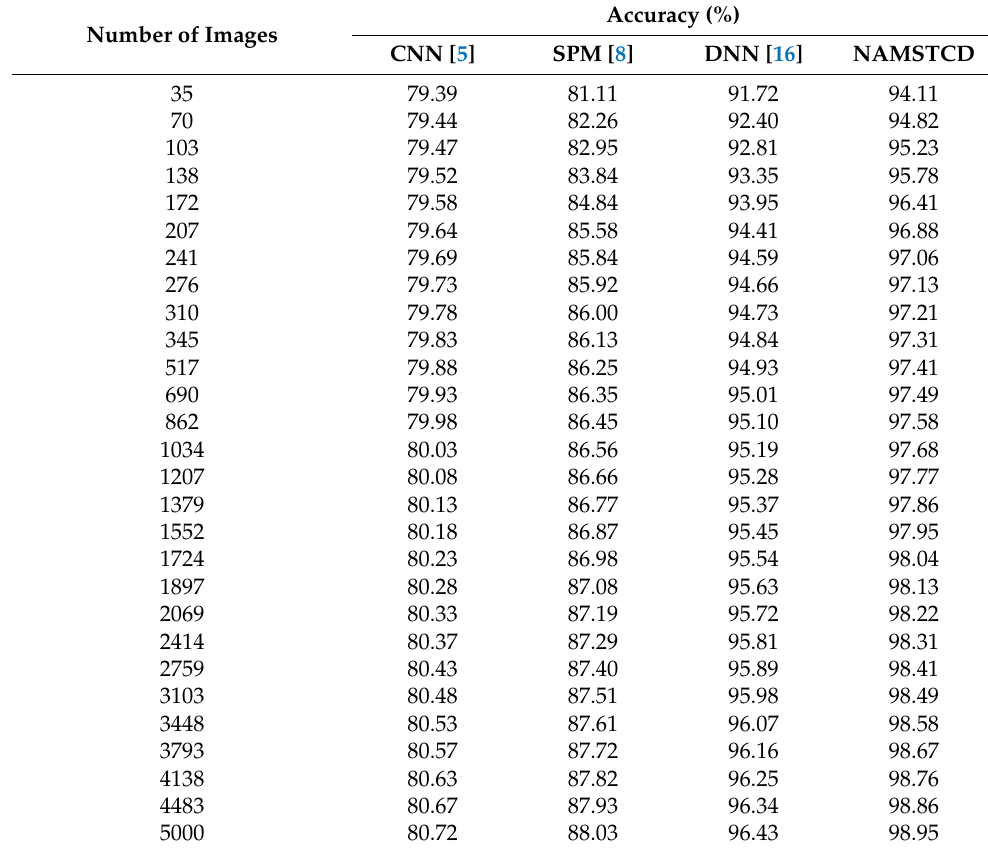
Table 2. Percentage accuracy of image classification using different models.